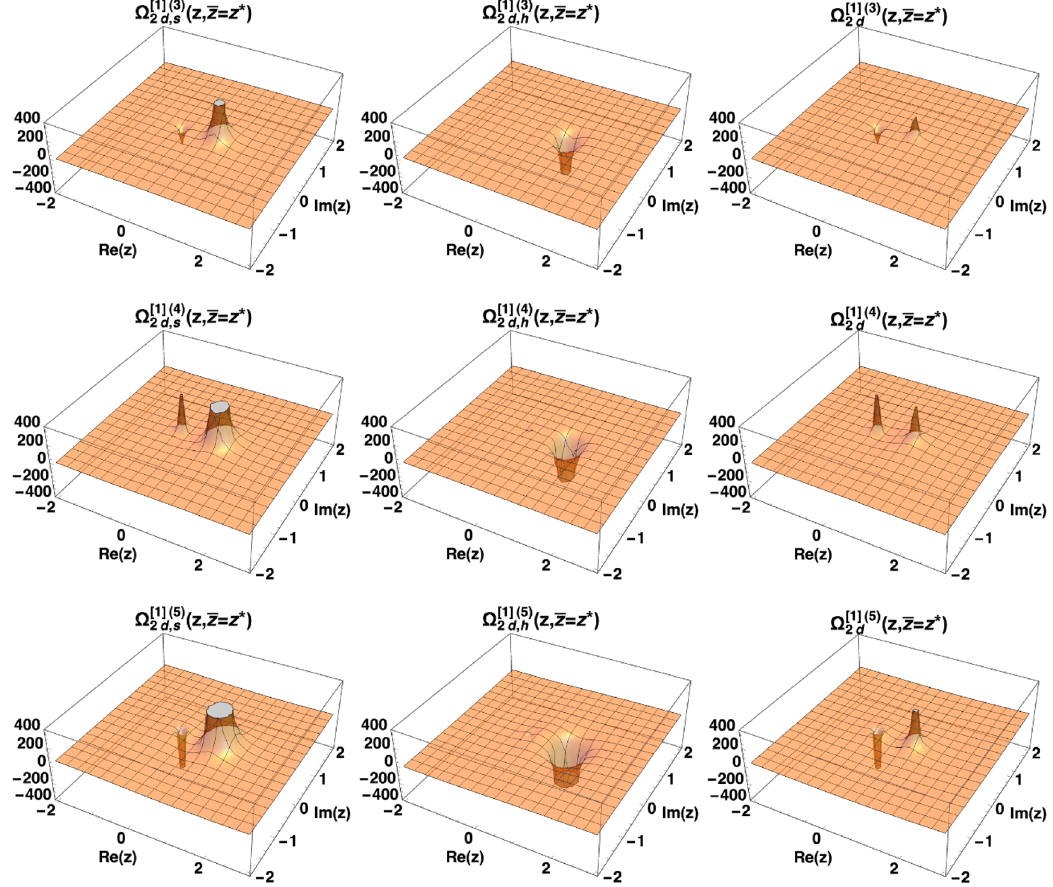
Figure 8 . Soft, hard and full wavefunction in the complex plane Re( z ), Im( z ). Here we plot the singlet component of the wavefunction. The soft and the full wavefunction exhibit singularities at z = 0 and z = , due to the z 1 =z symmetry, (the latter is not visible in the plots). In addition, 1 $ there is a singularity at z = 1, which appears also in the hard part of the wavefunction.